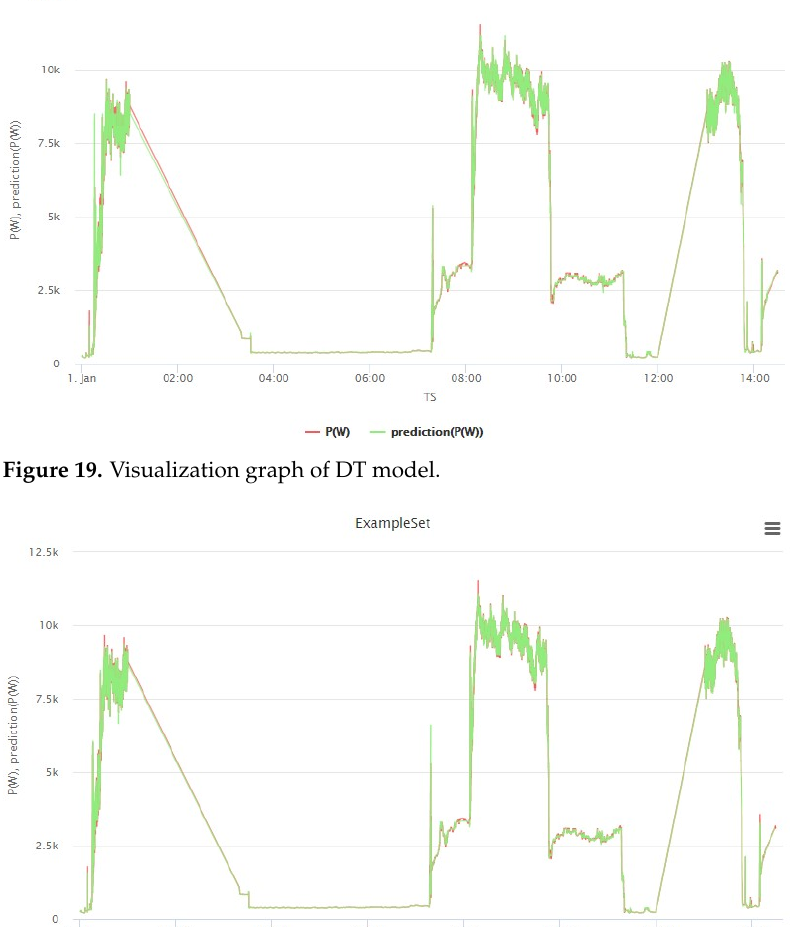
Figure 18. Visualization graph of ANN model.